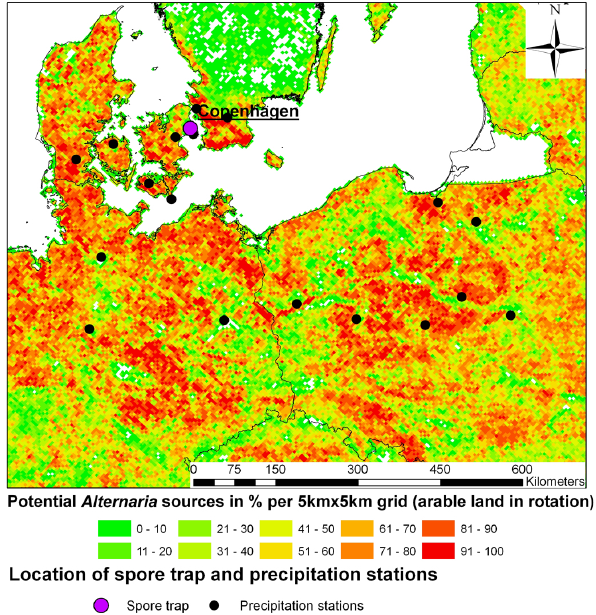
Fig. 2. Site map including the location of the spore trap in Copen- hagen, the used precipitation stations (Table A2) and the density of agricultural areas under rotation – the potential source of Alternaria spores during